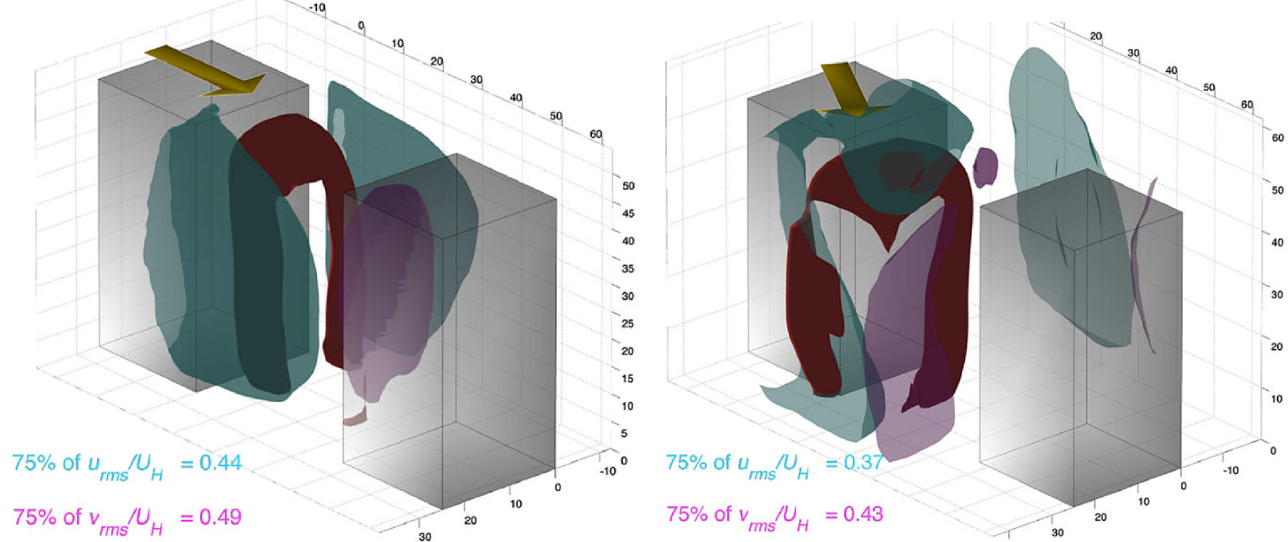
Figure 10. ( Left ) Isosurfaces of (red) Γ 1 = 0.4, (blue) streamwise and (purple) spanwise root-mean-squared (rms) fluctua- tions, showing thresholds equal to 75% of the value indicated on each panel, for AOI = 0 ◦ . ( Right ) Same as ( left ), with Γ = 0.35 and AOI = 30 ◦ . Reprinted from Ref. [87], with permission of the publisher (Springer 1